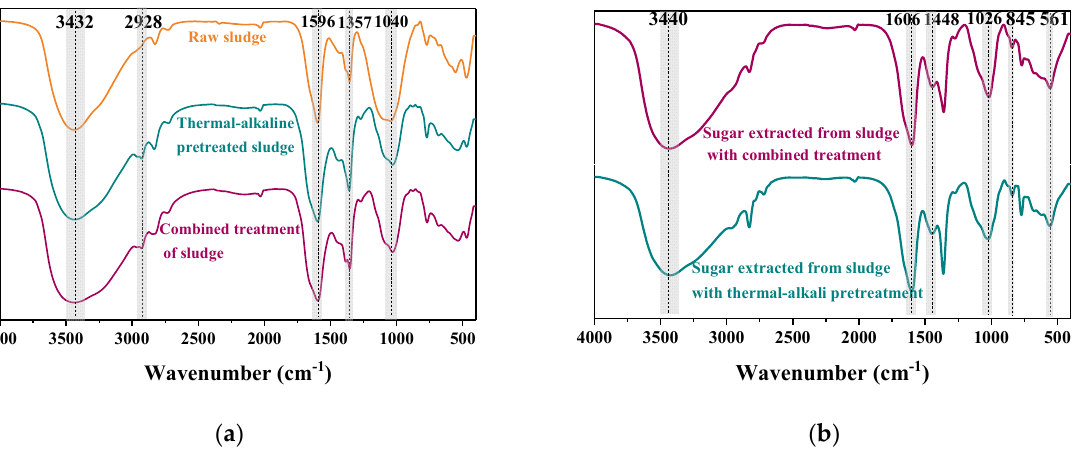
Figure 5. FTIR spectra of ( a ) raw sludge, thermal-alkaline pretreated sludge and sludge with micro- wave combined with thermal-alkaline pretreatment; ( b ) extracted sugars from sludge with com- bined pretreatment and thermal-alkaline pretreatment.